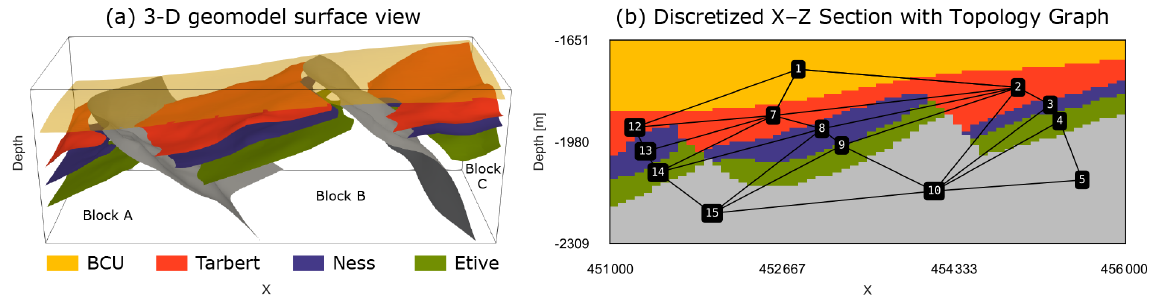
Figure 5. (a) 3-D view of the Gullfaks geomodel used as the mean prior model in our case study. (b) X–Z section through the discretized geomodel with an overlaid observed topology graph showing the inter- and intra-fault block relations of geobodies.